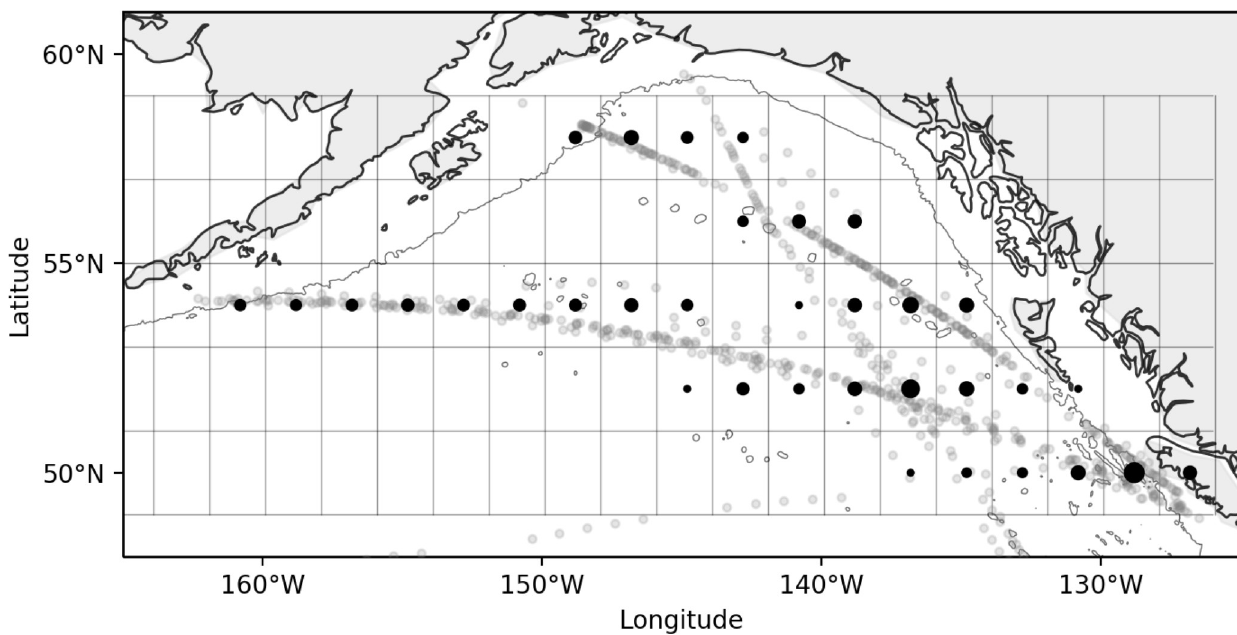
Fig 1. Map of the study area showing individual summertime CPR transects over 17 years (May 16-August 15, 2000–2016). Black circle within each grid cell depicts the center-point of the data (gray circles) which were averaged to produce abundance estimates for community analyses. Note that the center point is shown but sample locations may come from one part of the box only, especially for cells near to or including land. The size of each black circle scales to the sampling effort between grid cells. The coastal contour line depicts the 200 m isobath.